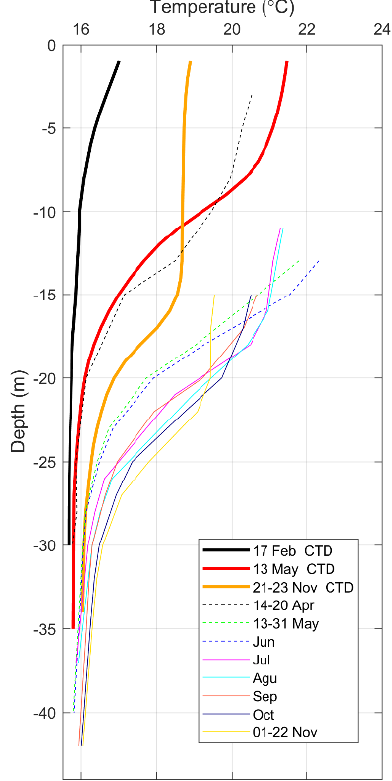
Figure 11. Continuous profiles of temperature obtained from the thermistor chain and from the CTD profiles. The legend indicates the month or day of the measurements. Thermistor chain data are shown as either continuous or dashed thin lines, whereas the CTD data are shown as continuous thick lines.